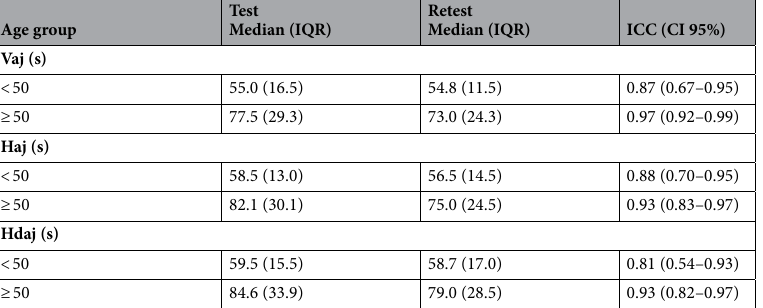
Table 1. Test–retest analysis of the adjusted times for the vertical and horizontal sheets of the ADEMd, the sample is subdivided according to age (younger than 50 years and 50 years old or more). Vaj vertical